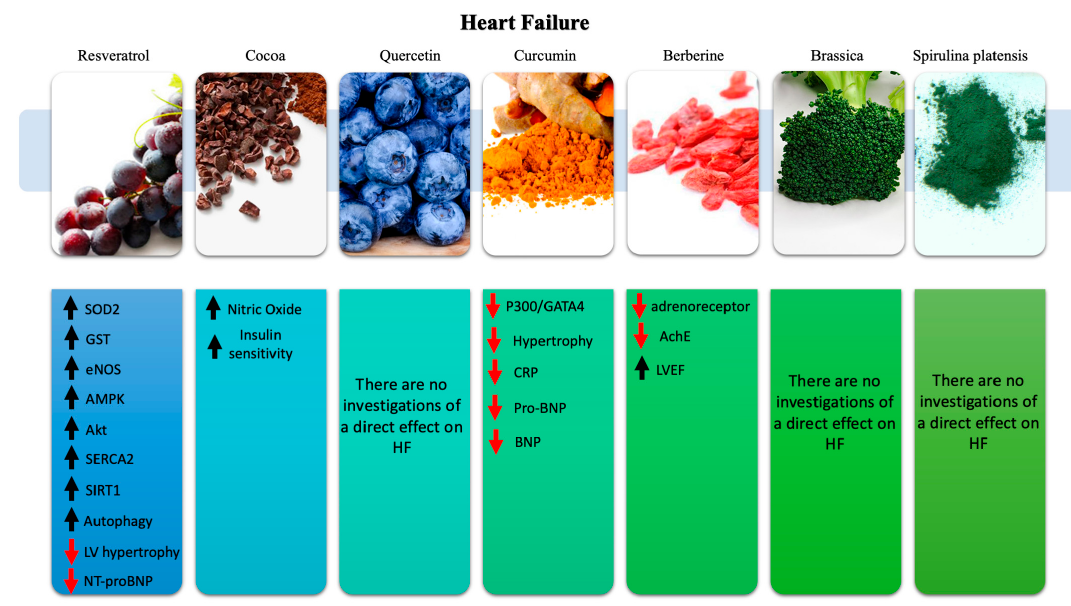
Figure 3. Summary of the main molecular and physiological e ff ects exerted by resveratrol, cocoa, quercetin, curcumin, brassica, berberine, and Spirulina platensis in HF. Red arrow ( ↓ ) indicates downregulation; black arrow ( ↑ ) indicates upregulation.